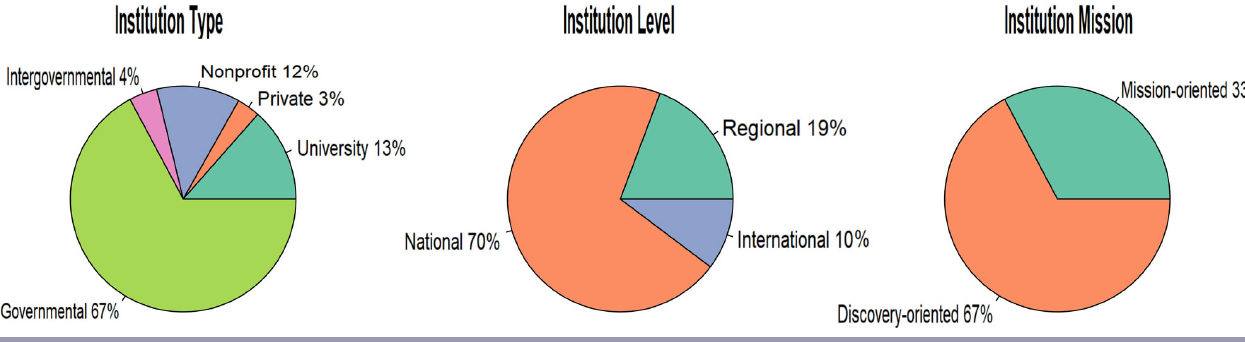
Fig. 4 . Distribution of 1045 funding entities supporting peer-reviewed studies focusing on disaster-related ecological concerns differentiated by (A) type of institution, (B) geographic scope of the institution, and (C) aims of the